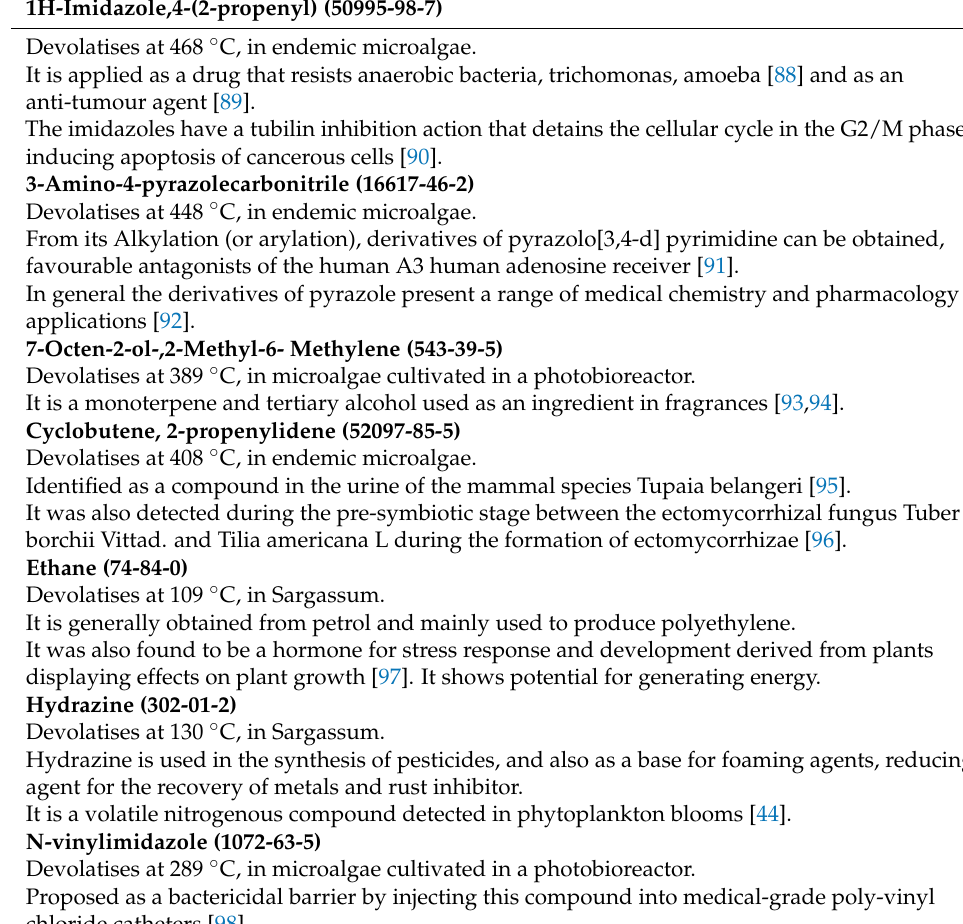
Table 9. Volatile compounds detected in the TG-GC/MS coupling analysis of the algal biomass during